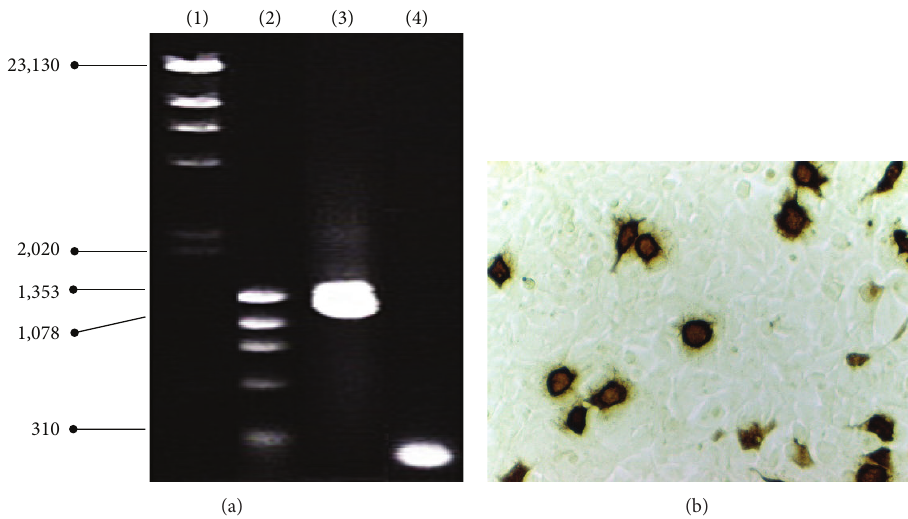
Figure 1: Definition of viral titers. (a) pAdenoX encoding human bmp2 was identified using 2% agarose gel electrophoresis after PCR amplification with two primer sets. Lane 1: 𝜆 - Hind III digest; lane 2: 𝜑 X 174- Hae III digest; lane 3: full sequence human bmp2 (1191bp); lane 4: partial sequence human bmp2 (225 bp). (b) HEK293 cells were infected with adenovirus encoding bmp2 , which demonstrated a titer of 5.85 × 10 6